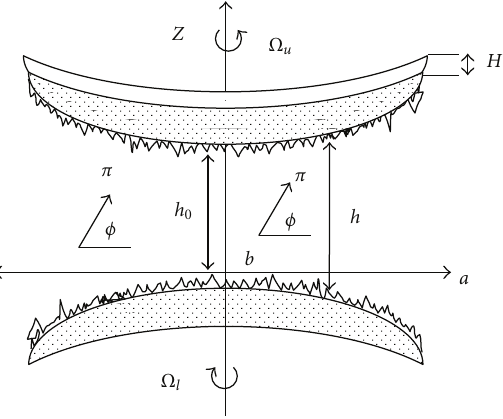
Figure 1: Configuration of bearing